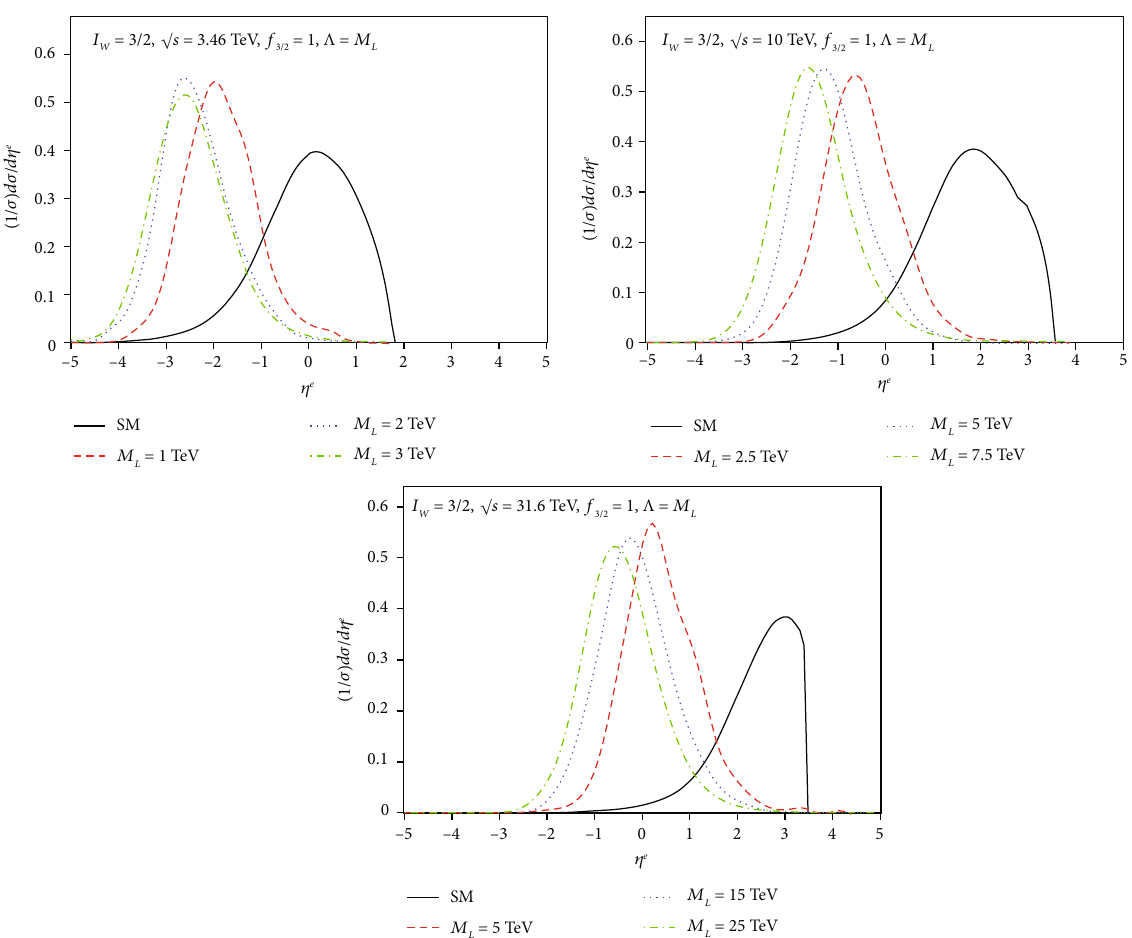
= 3/2 multiplet for f W